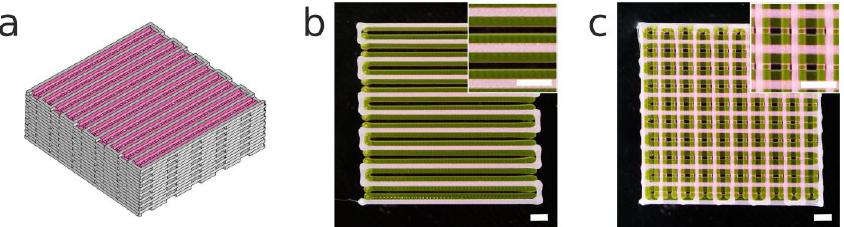
Figure 8. ( a ) A CAD model of a 3D hybrid construct of dimensions 20 × 20 mm. ( b ) The first layer and ( c ) stack of two layers printed of the hybrid construct. It is composed of PCL (ID: 437 µ m; 14 mm s − 1 ; 140 ◦ C; 700 kPa) and intercalated filaments of poloxamer P407 (ID: 200 µ m; 14 mm s − 1 ; room temperature (RT); 100 kPa). Scale bars: 2 mm.